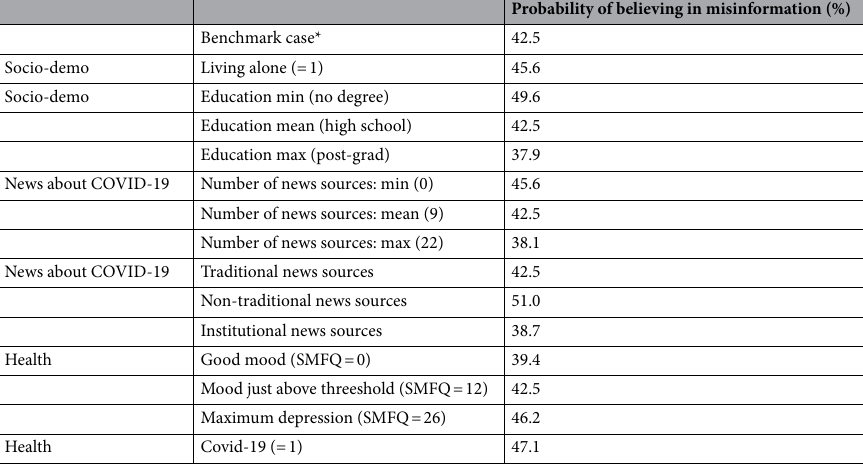
Table 2. Probabilities of believing in misinformation for different categories of citizens. *The estimates in the table refer to a probit panel data model (i.e., model I Table 1), with robust standard errors. The benchmark case has been calculated as follows: average age (i.e., years = 49), living in a family, high-school education, average number of news sources on COVID-19 (i.e., 9), SMFQ index = 12, no COVID-19 in family.